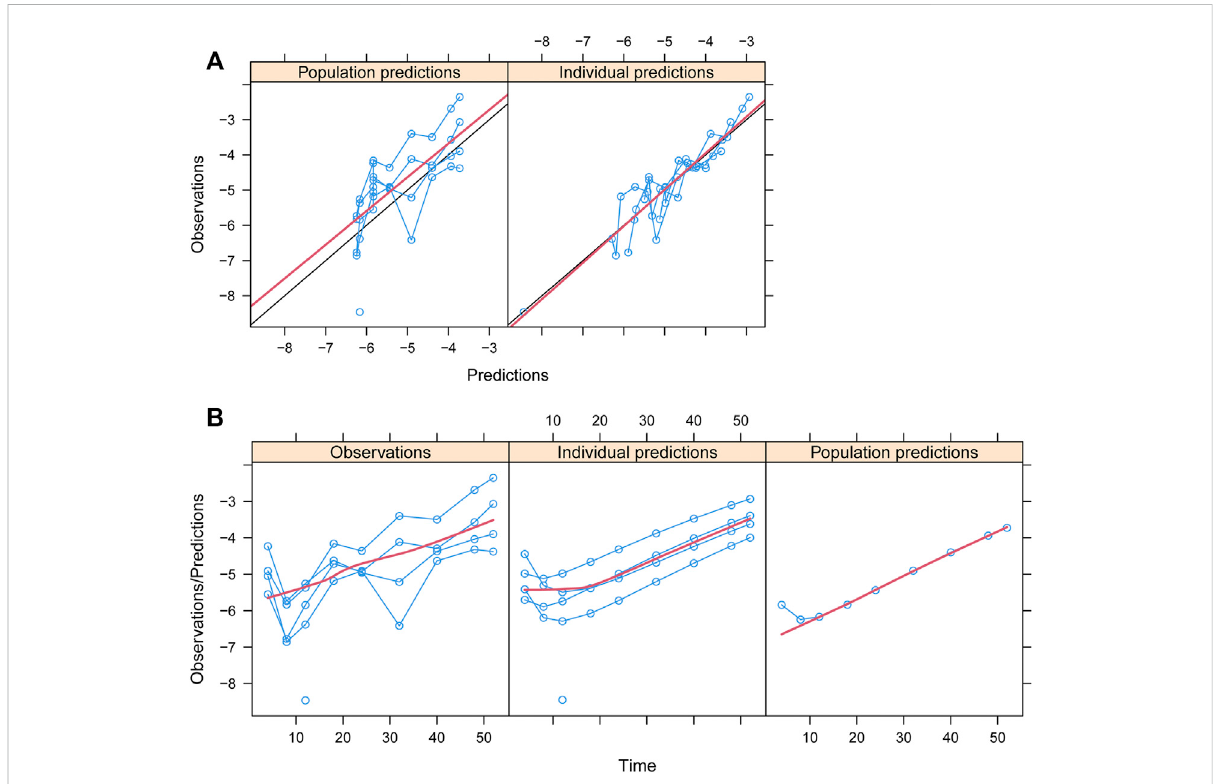
FIGURE 1 Goodness-of- fi t plots of the model. (A) Observations vs. predictions and (B) observations/predictions vs. time. Blue smooth lines represent the trend of an individual study. Red smooth lines represent the trend of all